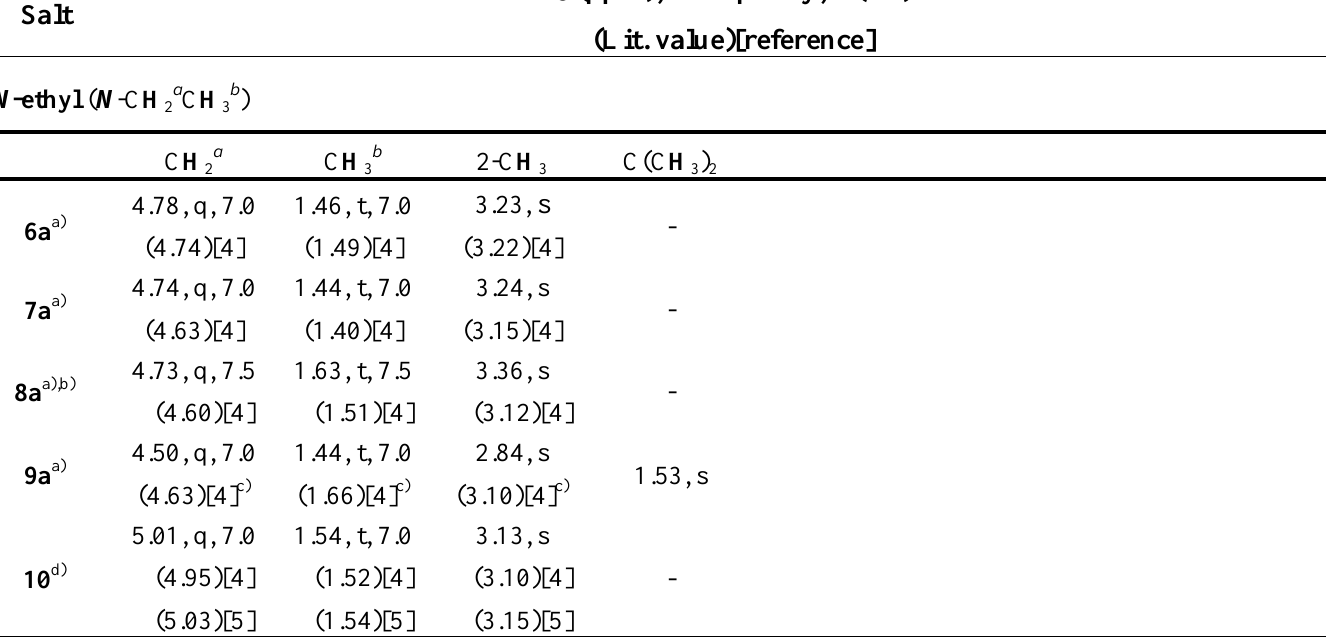
δδδδ (ppm), multiplicity, J (Hz) (Lit.